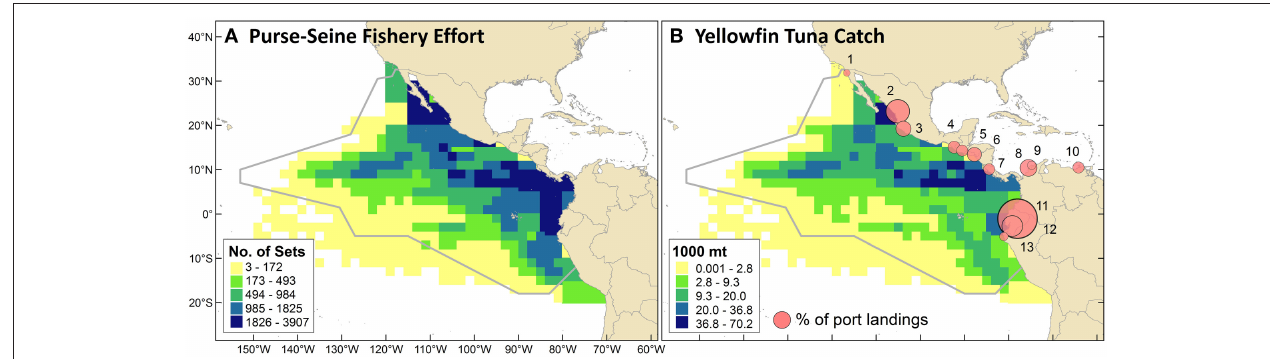
FIGURE 4 | (A) Commercial purse-seine fishery effort as the cumulative number of sets from 1986 through 2006. (B) Yellowfin tuna catch (cumulative mt) in the purse-seine fishery over the same period. Proportional circles depict the percentage of annual purse-seine landings (all species) brought to different ports in 2010–2011. Landings were distributed as follows, with numbers corresponding to map locations: (1) Ensenada, Mexico (1%); (2) Mazatlan, Mexico (14%); (3) Manzanillo, Mexico (6%); (4) Puerto Chiapas, Mexico (4%); (5) Puerto Quetzal, Guatemala (3%); (6) La Union, El Salvador (5%); (7) Puntarenas, Costa Rica (3%); (8) Cartagena, Colombia (7%); (9) Barranquilla, Colombia (2%); (10) Puerto Sucre, Venezuela (3%); (11) Manta, Ecuador (40%); (12) Posorja, Ecuador (11%); (13) Paita, Peru (2%).